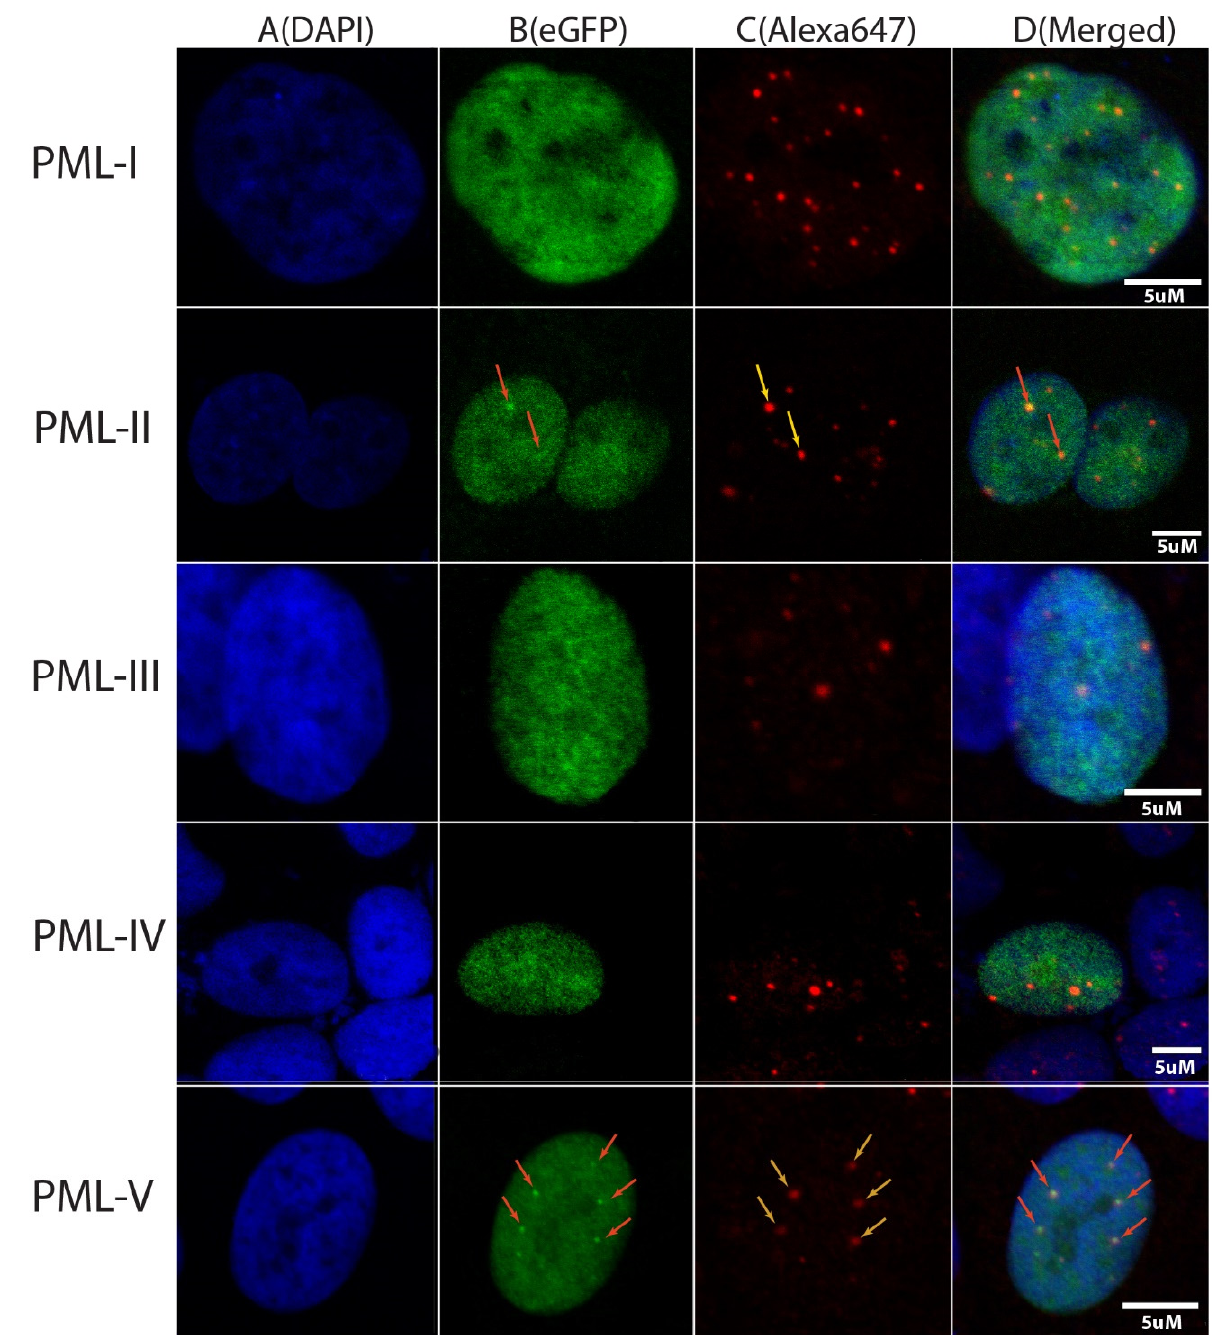
Figure 2. Colocalization of endogenous PML-bodies and C-terminal domains of PML isoforms in the HeLa cells using confocal fluorescent microscopy. Nucleus are colored by DAPI (column ( A )). C-terminal domains of PML isoforms are visualized by expression of chimeric proteins EGFP fused with C-terminal domain of appropriate PML isoform (column ( B )). The endogenous PML-bodies are visualized by cells staining with Anti-PML Alexa Fluor 647 antibodies (column ( C )). Merging of images in columns ( A – C ) (column ( D )).